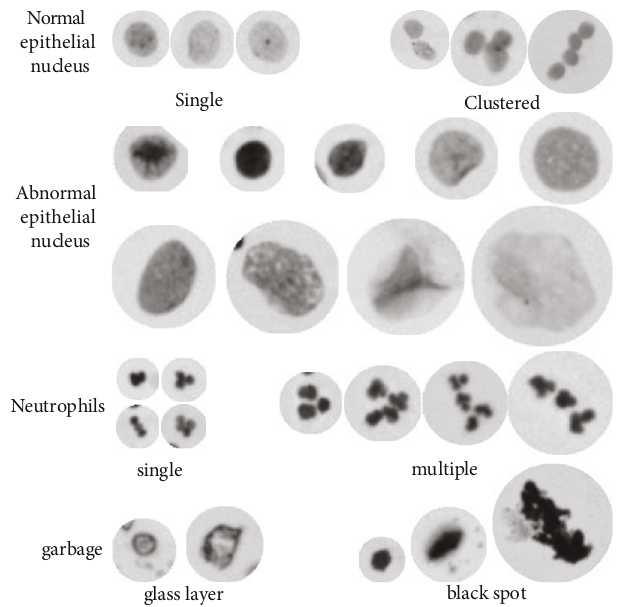
Figure 1: Microscopic cell